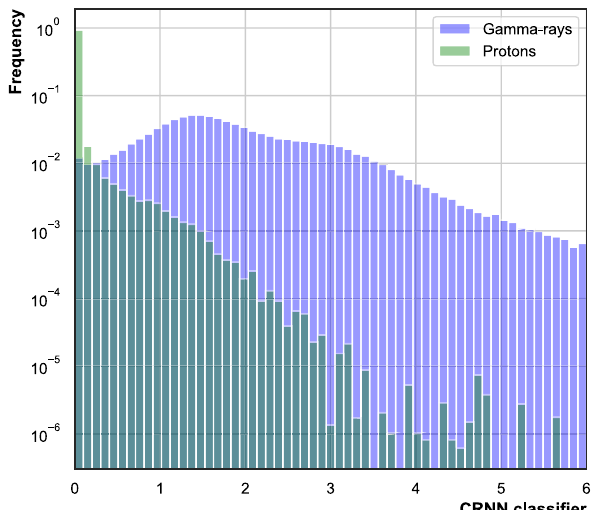
Fig. 4 Distribution of the CRNN classifier for a sample of gamma- ray and proton events. Events are re-weighted to represent an energy spectrum of E − 2 for both signal and background